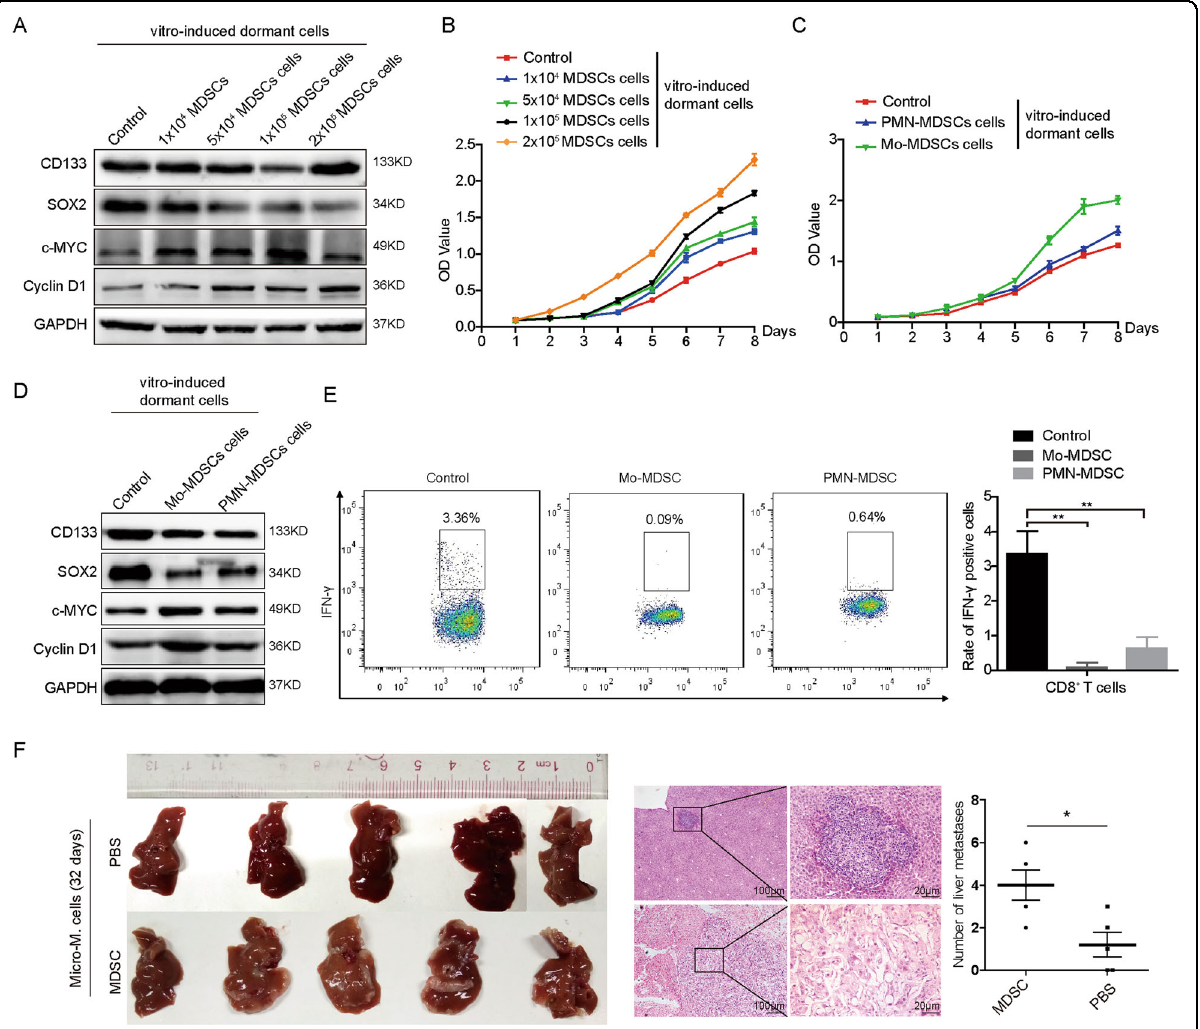
Fig. 3 MDSCs activate dormant cell growth. A CD133, SOX2, c-Myc, and Cyclin D1 protein expressions in micro-metastatic cells or vitro-induced- dormant cell co-cultured with different numbers of MDSCs was detected by western blot. B Vitro-induced-dormant cells proliferation with different numbers of MDSCs co-culture were detected by CCK-8. C Vitro-induced-dormant cells proliferation with Mo-MDSCs or PMN-MDSCs co-culture were detected by CCK-8. D CD133, SOX2, c-Myc, and Cyclin D1 protein expressions in vitro-induced-dormant cells with Mo-MDSCs or PMN-MDSCs co- culture were detected by western blot. E IFN- γ in CD8 + T cells with Mo-MDSCs or PMN-MDSCs co-culture were detected by Flow cytometry. F Effect of Mo-MDSCs on promoting HT29 cells metastasis in